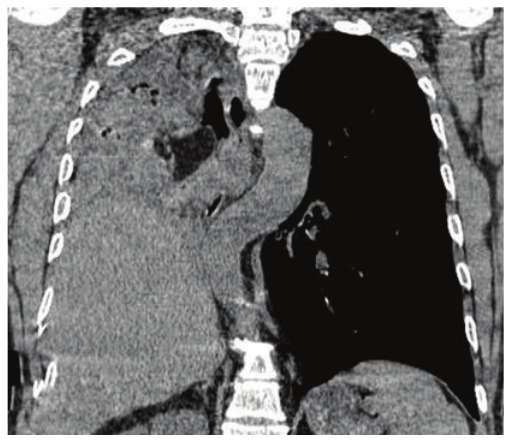
Figure 3: Reformatted reconstruction showed adipose mass oc- cluding the right main bronchus and right lung atelectasis.